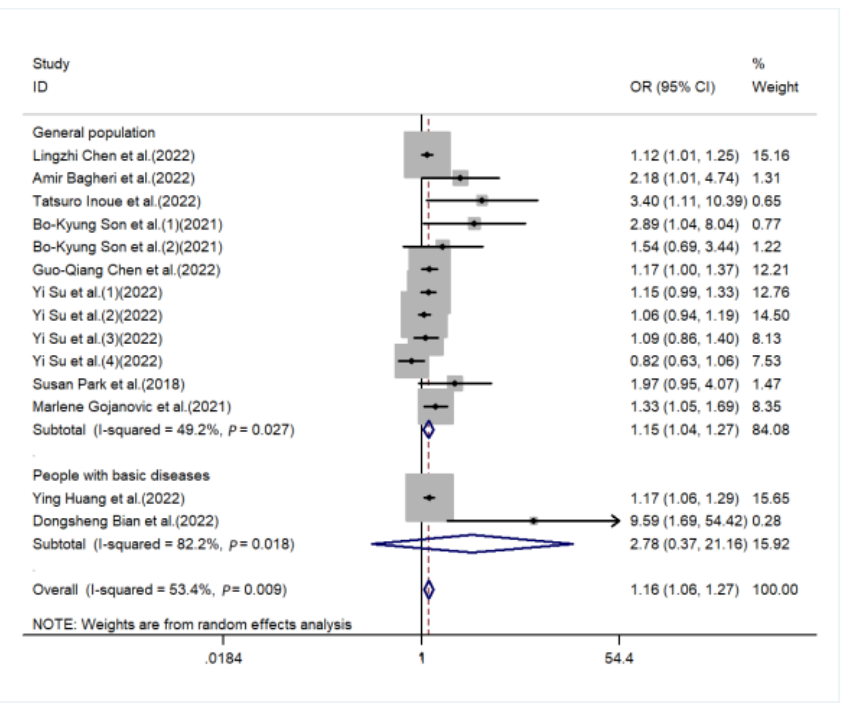
Figure 6. Forest plot for the subgroup of basic disease [20,22,24–30].